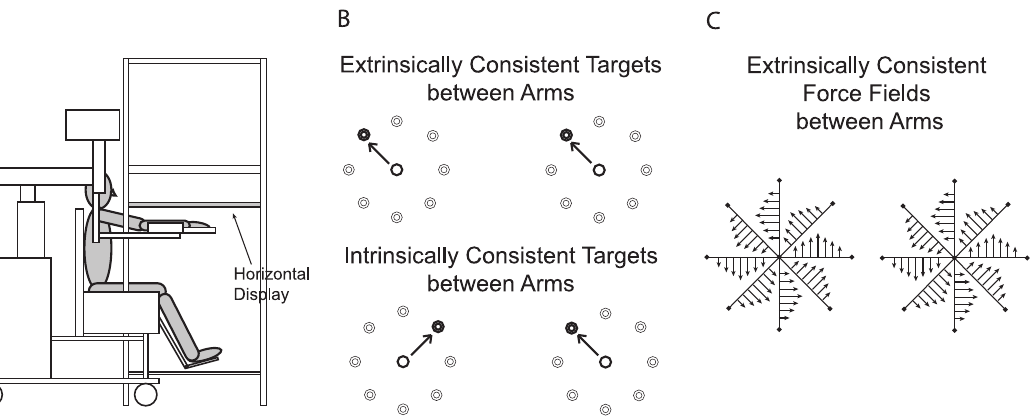
Figure 1. Experimental setup. A, Side view: subject sat on the KINARM chair with the arms placed under the horizontal display. B, Target was randomly displayed on one of eight target locations for each arm. Target directions were either extrinsically (top) or intrinsically (bottom) consistent between the arms during the bilateral session. C, Direction of a velocity-dependent force field applied to each arm during reaching movement. Longer arrows indicate greater forces. Force directions were always extrinsically consistent between the arms.